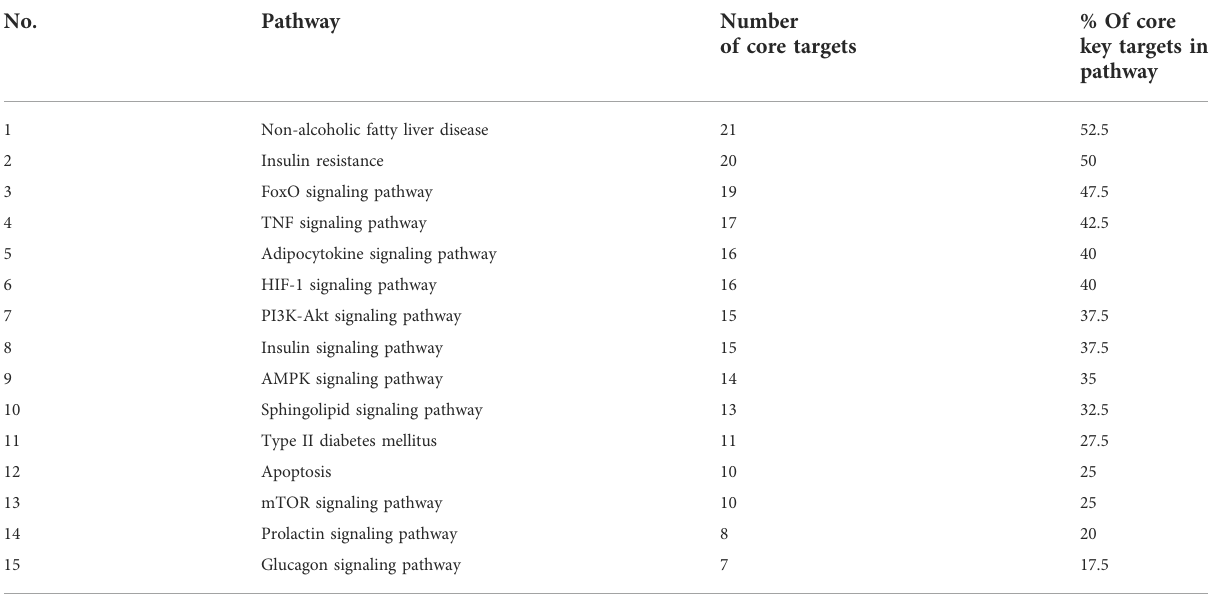
TABLE 5 Shows the relationship between core key targets and